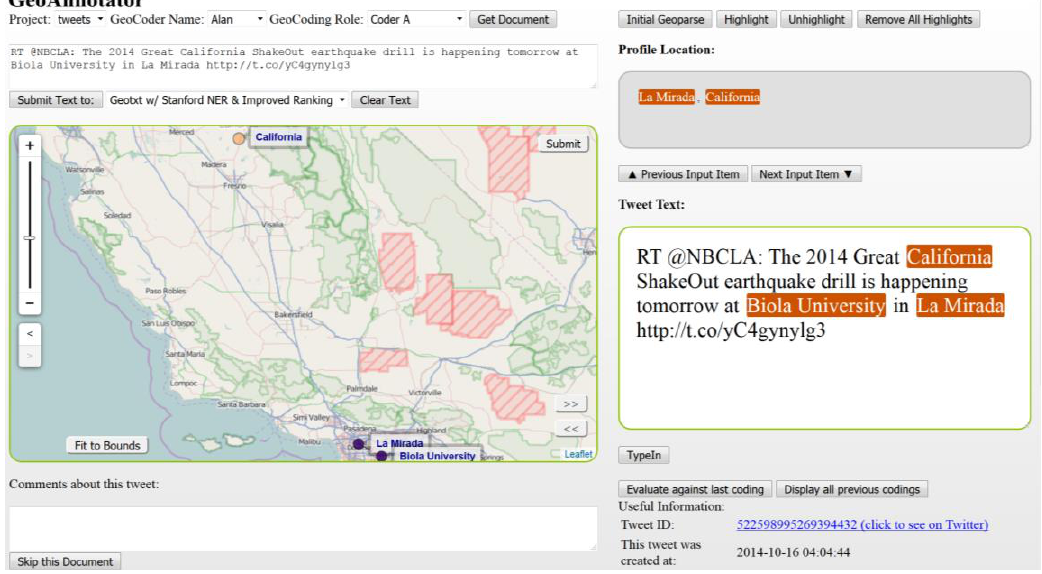
Figure 1. GeoAnnotator’s user interface (UI) main window during the initial stages of development. The panel on the right shows the text that is already annotated for named entities and fed into the platform. Place names are highlighted in orange. The panel on the left shows the map interface where highlighted named entities are mapped using a pre-generated list of toponyms through pre-processing. If the default toponym is not the correct one, users can click on it, retrieve a list of “alternative toponyms” and select the correct one. There is often some context that makes it possible for a human annotator to identify the correct toponym, either within the tweet itself, from the profile information and/or from URLs that may be included in the tweet. The interface provides a link to the original tweet on Twitter so that the annotator can search for more context if necessary.